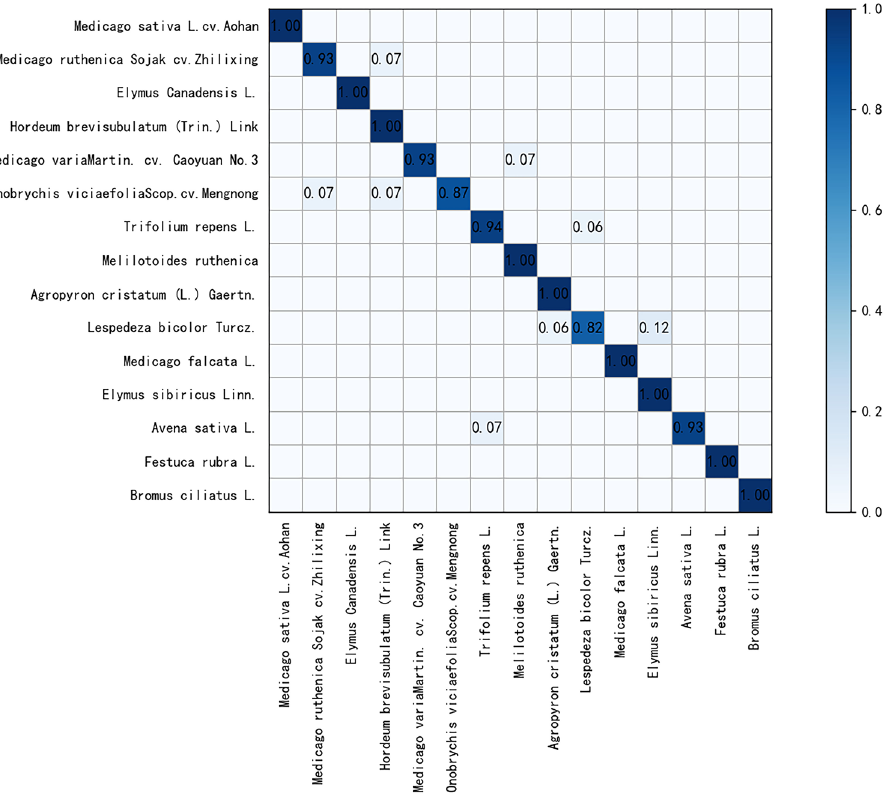
Figure 7. CM of the Grass1 dataset in MSM–EAL